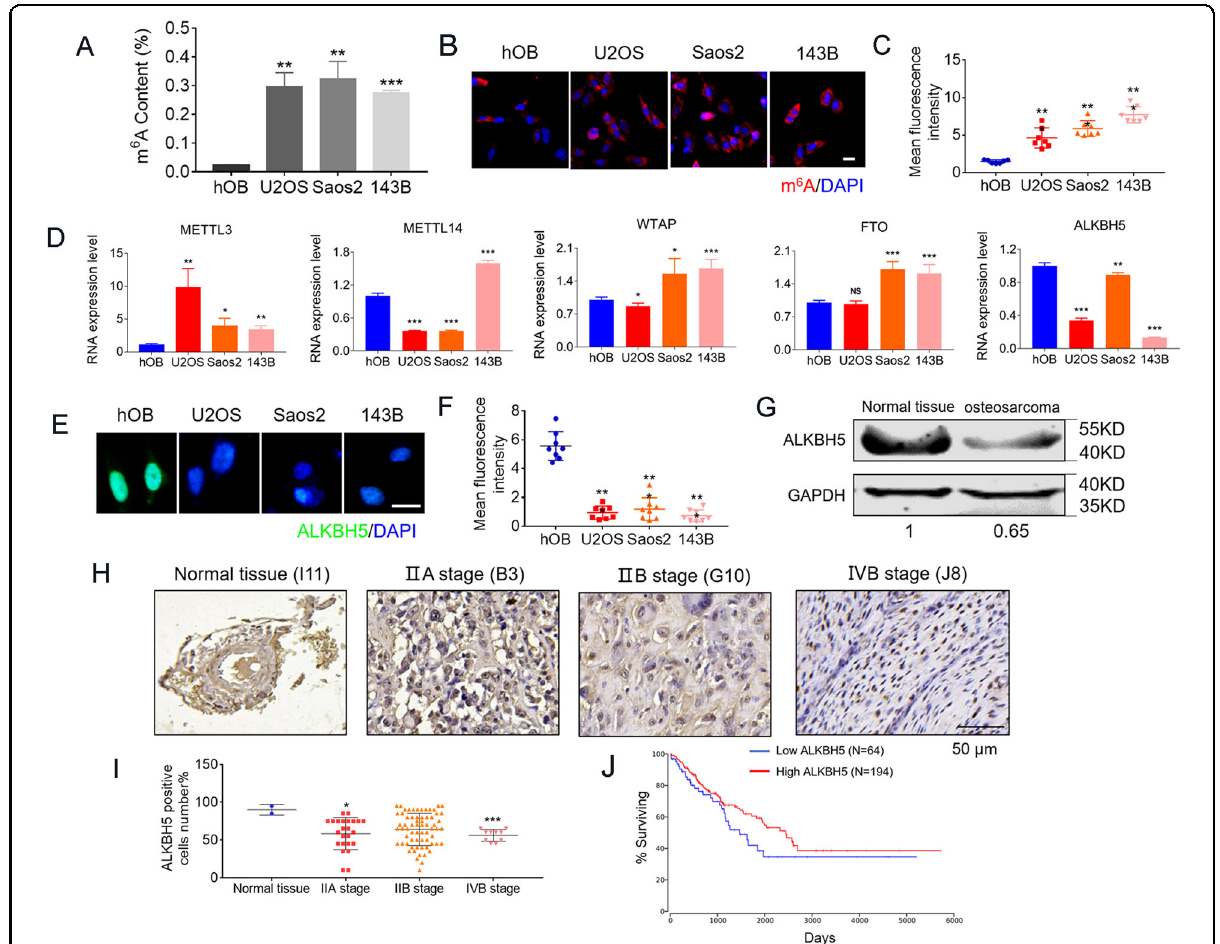
Fig. 1 Increased m 6 A modi fi cation level together with the reduced expression of demethylase ALKBH5 in human osteosarcoma. A m 6 A ELISA experiments ( n = 3) showing the increase of global m 6 A level in RNAs in human osteosarcoma cell lines compared with human osteoblasts (hOB) cell line. B Representative confocal microscopy images with m 6 A (red) and DAPI (blue) of human osteosarcoma cells compared with hOB cells ( n = 7, Bar: 25 μ m). C Bar graph showing the quanti fi cation of mean in fl uence intensity of m 6 A positive cells. D Expression of individual m 6 A modi fi ers in human osteosarcoma cells compared with hOB cells. E Immunostaining for anti-ALKBH5 in hOB cells and osteosarcoma cells ( n = 8, Bar: 25 μ m). F Bar graph showing the quanti fi cation of mean in fl uence intensity of ALKBH5 positive cells. G Western blot showing the protein expression of ALKBH5 in normal tissues and osteosarcoma tissues. H Immunohistochemistry (IHC) analysis of ALKBH5 protein expression on tissue microarrays (TMAs) composed of benign bone tissues ( n = 2), IIA stage osteosarcomas ( n = 24), IIB stage osteosarcomas ( n = 66) and IVB stage osteosarcomas ( n = 10) tumor cores. Representative IHC images (magni fi cation ×80) are presented (upper, Bar: 50 μ m). I Bar graph representing the percentages of ALKBH5 positive cells number (lower). J Kaplan – Meier survival curve indicates the difference in survival rate between ALKBH5 high expression and ALKBH5 low expression patients. Data are expressed as mean ± SEM. * P < 0.05; ** P < 0.01; *** P <